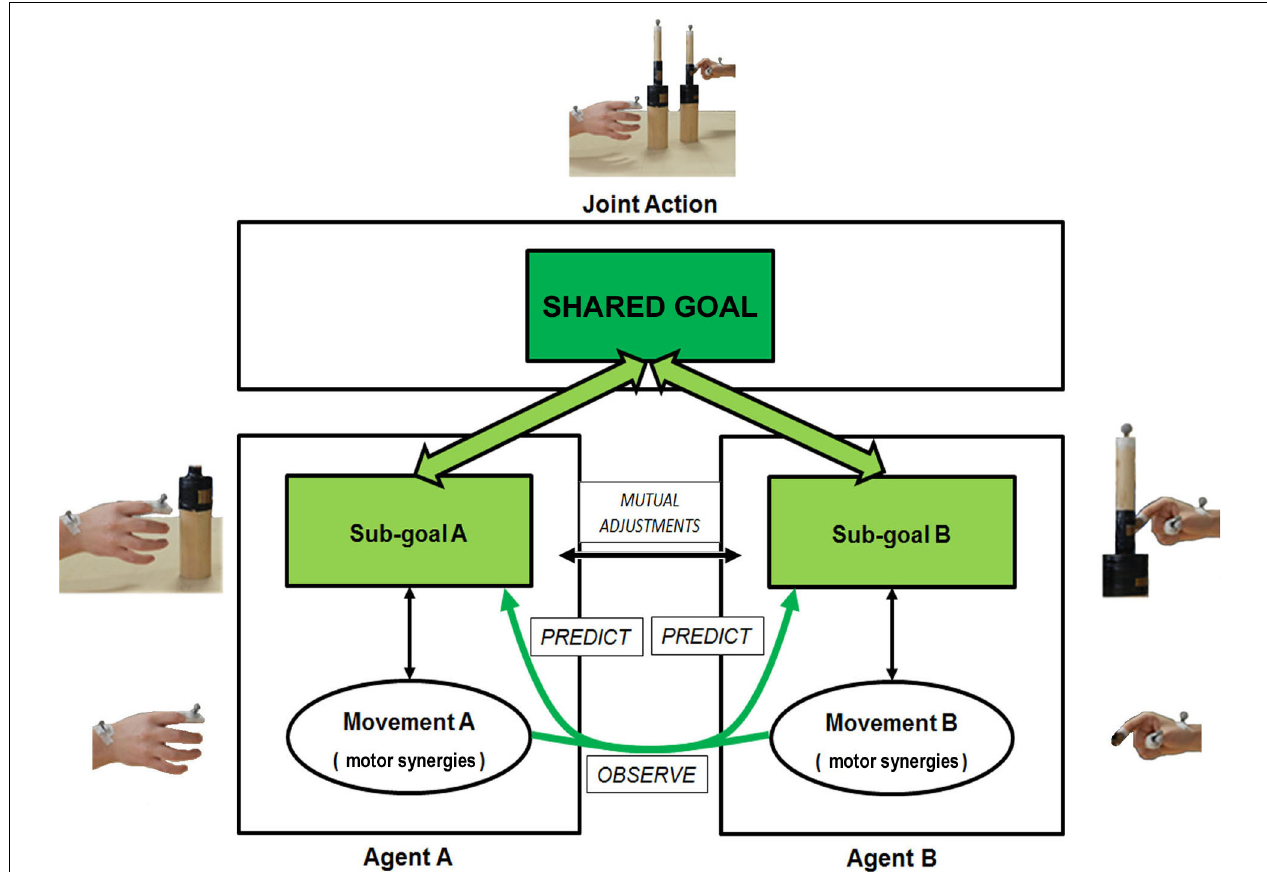
FIGURE 1 | The figure illustrates how a joint-grasping set-up allows for investigating the hierarchical structure of motor planning which characterizes joint action (JA). It represents the JA experimental condition described in the main text. Here, each agent’s sub-goal (i.e., grasping the bottle-shaped object at the correct location) depends on the couple’s shared goal (i.e., grasping the object synchronously and performing a complementary/imitative action, please note in this case a complementary